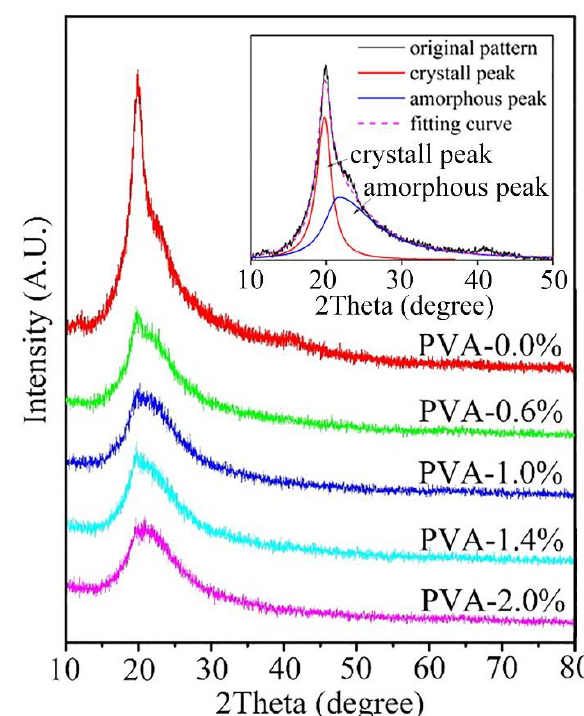
Figure 2. XRD curves of PVA powder containing 0.0%, 0.6%, 1.0%, 1.4%, and 2.0% of ferric ions (the inset is a typical fitting and simulation process of the crystalline fraction calculation). Table 1. Crystalline fraction of PVA samples calculated from the XRD curves.